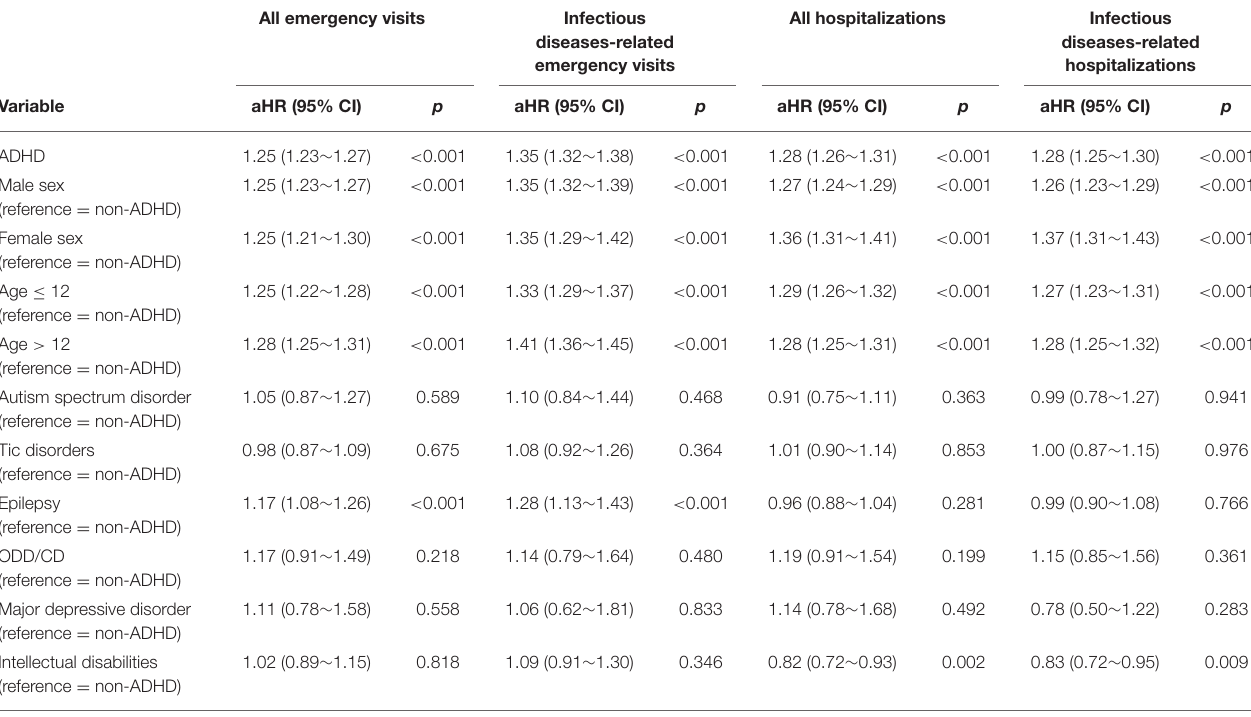
TABLE 2 | Cox proportional hazard regression analysis with propensity score matching for risks of infectious diseases-related emergency room visits and hospitalizations between ADHD and non- ADHD youths stratified by demographic variables and